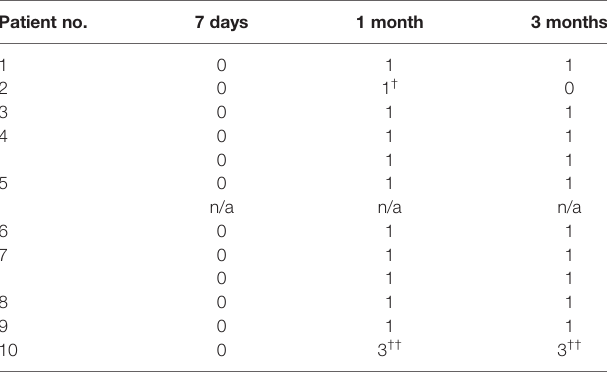
TABLE 3 | Adverse events (in general mild cases of local alopecia, leukotricia, dry desquamation, mild erythema or swelling) graded using the VRTOG grading scheme for adverse events following